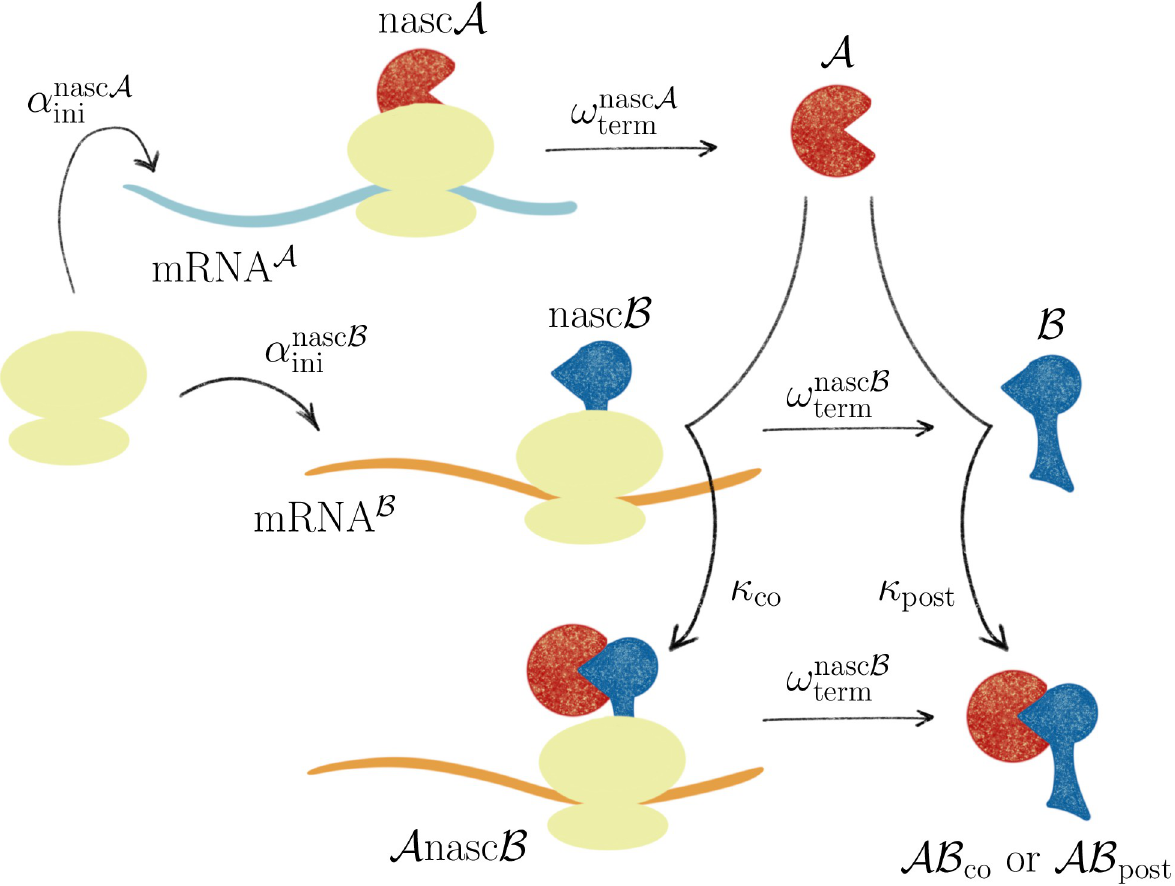
Fig 1. Post- and co-translational assembly of protein complexes. Ribosomes (yellow) bind to mRNA molecules (colored lines) with time- and position-dependent initiation rates a nasc A ð ~ x ; ~ t Þ and a nasc B ð ~ x ; ~ t Þ , and synthesize protein subunits A and B with constant rates o nasc A ini ini respectively. Subunit A can bind subunit B co- or post-translationally with binding rate constants κ co and κ post , respectively. In contrast, nascent subunit nasc A cannot be bound by subunit B